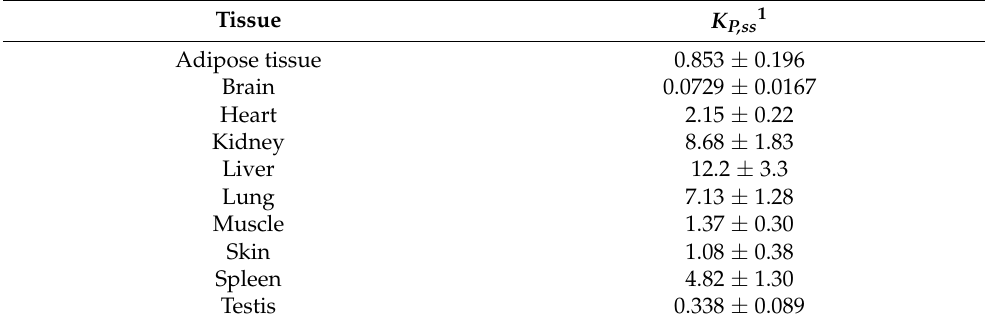
Table 2. Tissue-to-plasma concentration ratio at a steady state of IDP-73152 in rats ( K P,ss ).